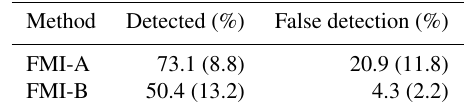
Table 1. Comparison of the FMI methods to AARI ice charts; the numbers are in percents. The values in parentheses are standard de- viations in percentage points of the AARI ice chart LFI.